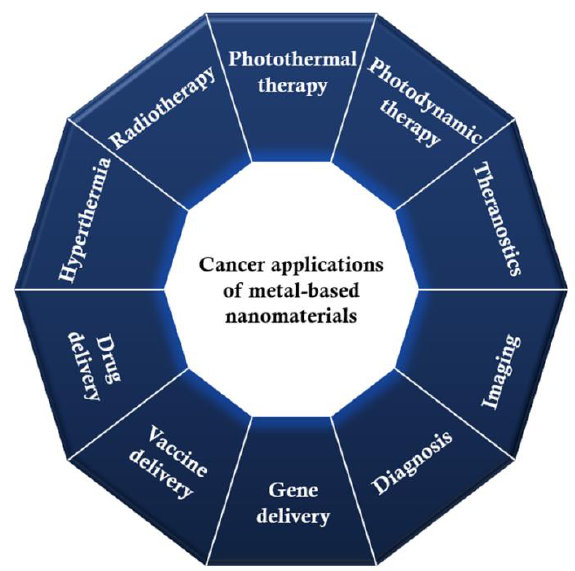
Figure 7. Applications of metal-based nanomaterials in cancer management.